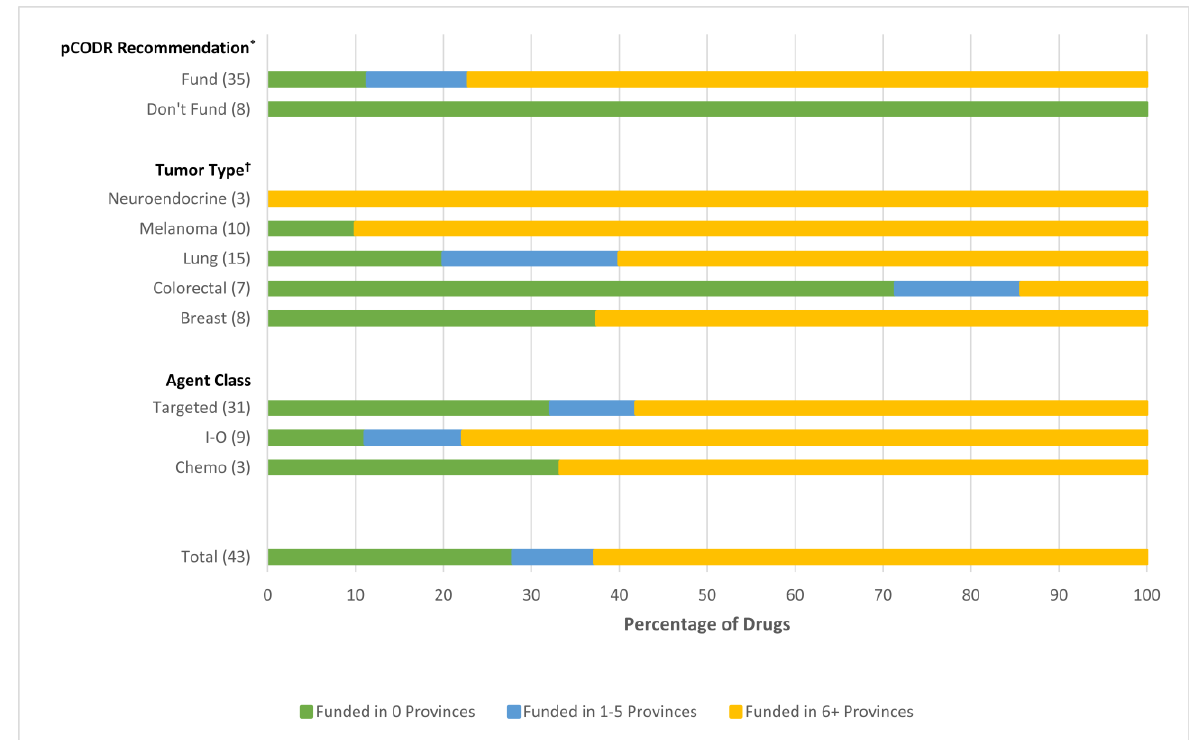
Figure 2. Determinants of drug funding * p < 0.0001, † p = 0.0347. Abbreviations: I-O, immuno- therapy.